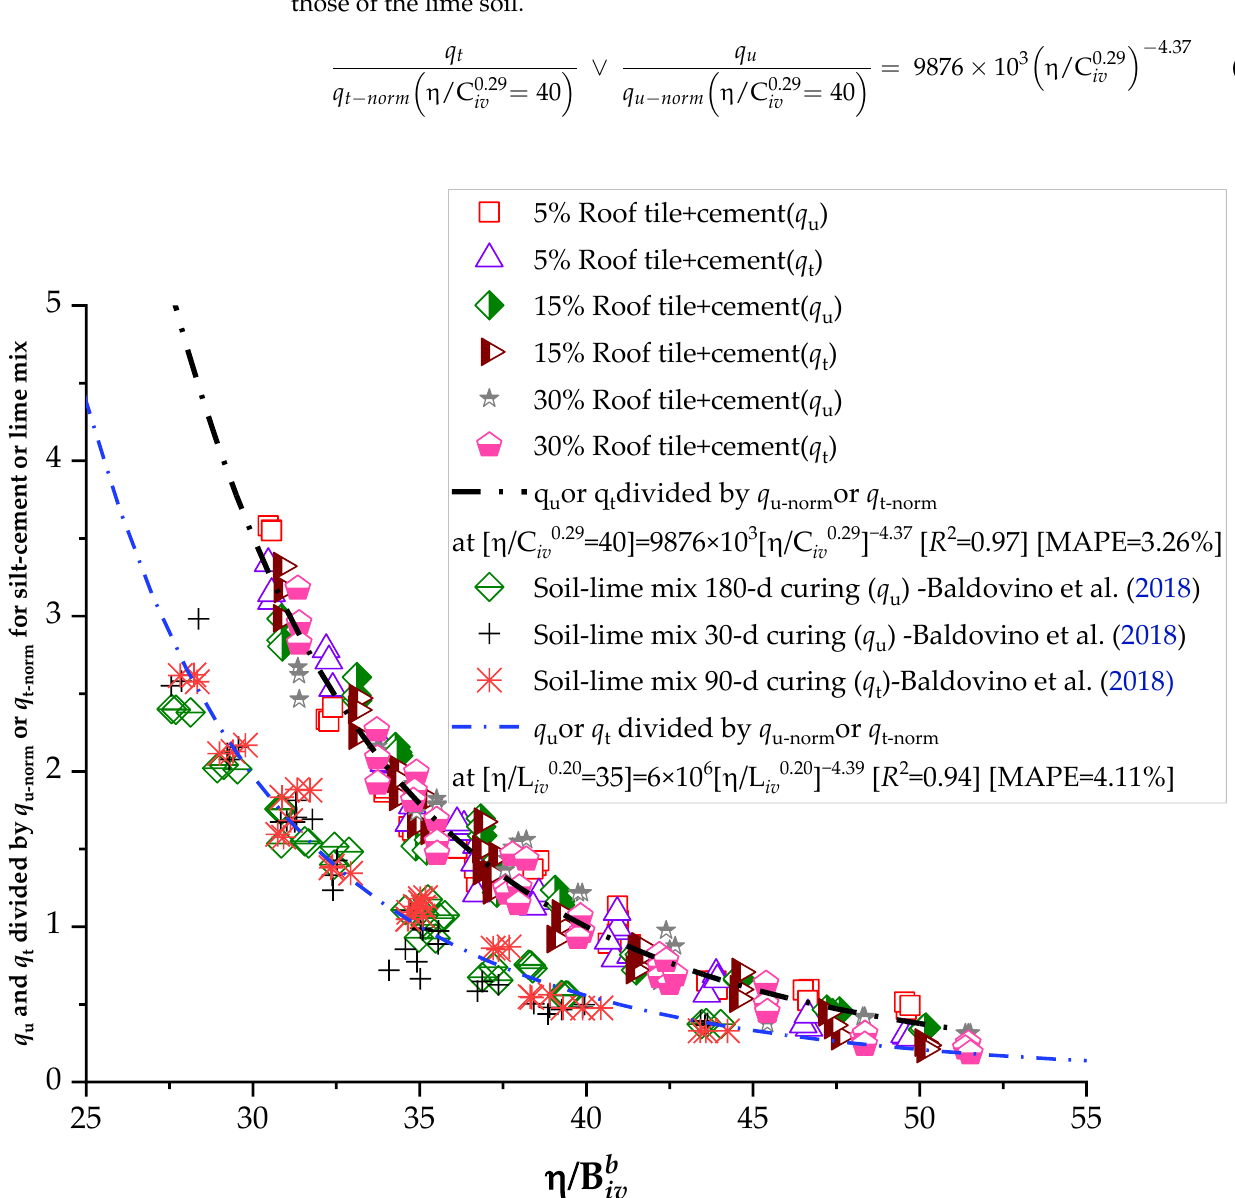
Figure 9. Normalization of the unconfined compressive and splitting tensile strength (for the whole range of porosity/cement index-adjusted to 0.29 exponent) by dividing for q u and q t at porosity/cement = 40, considering the strength of the cement-treated silty soil-roof tile waste mixtures; and the normalization of strength (for the whole range of porosity/lime index-adjusted to the 0.20 exponent) by dividing for q u and q t at porosity/lime = 35, considering the strength of the dolomitic hydrated lime-treated silty soil, reported by Baldovino et al. [50].